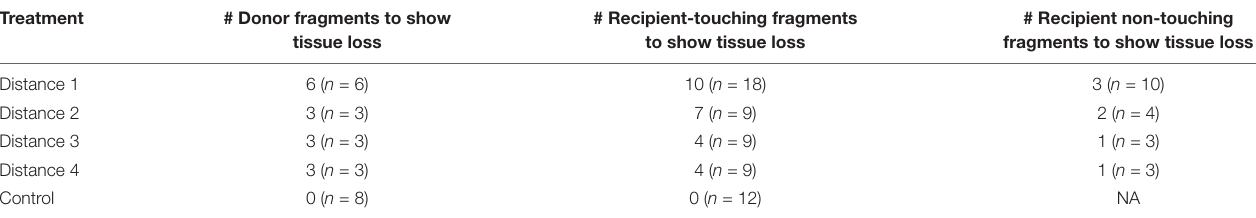
TABLE 6 | Experimental design for the M. cavernosa to O. faveolata experiment with monitored lesion progression on donor and recipient fragments. Treatment # Donor fragments to show # Recipient-touching fragments tissue loss to show tissue loss